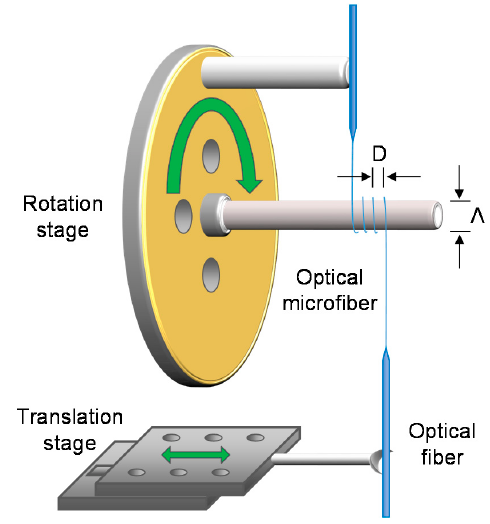
Figure 3. Schematic diagram of a coiling rig setup.